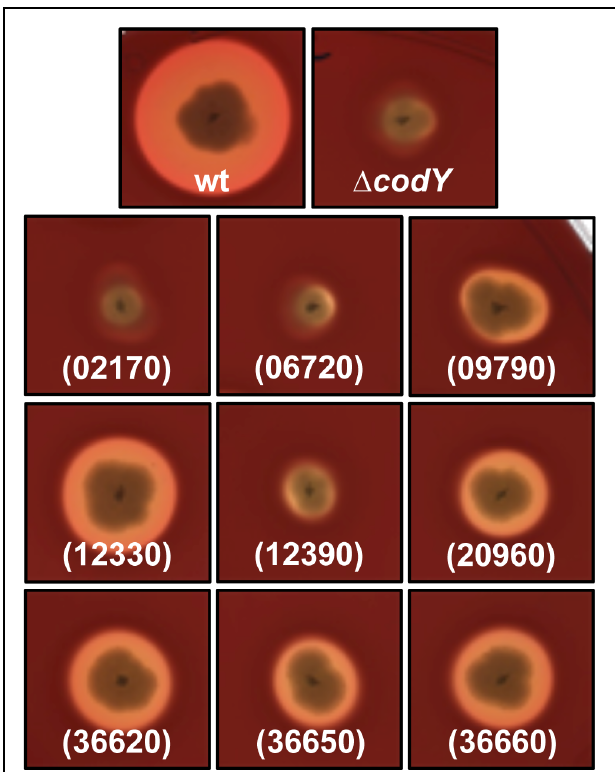
FIGURE 9 | Hemolytic activity of (cid:2) codY cells over-expressing oppA and oppA -like-encoding genes. Cells were patched onto a Columbia sheep blood agar plate supplemented with xylose and grown at 37 ◦ C for 16 h. The cells either harbor the empty vector p304-P xyl + or overexpress our gene of interest under the control of a xylose-inducible promoter. wt, Bt 407- (p304-P xyl + ); (cid:2) codY , Bt (cid:2) codY (p304-P xyl + ); (02170), Bt (cid:2) codY (p304-P xyl + -02170); (06720), Bt (cid:2) codY (p304-P xyl + -06720); (09790), Bt (cid:2) codY (p304-P xyl + -09790); (12330), Bt (cid:2) codY (p304-P xyl + -12330); (12390), Bt (cid:2) codY (p304-P xyl + -12390); (20960), Bt (cid:2) codY (p304-P xyl + -20960); (36620), Bt (cid:2) codY (p304-P xyl + -36620); (36650), Bt (cid:2) codY (p304-P xyl + -36650); (36660), Bt (cid:2) codY (p304-P xyl + -36660). This picture is representative of at least three independent